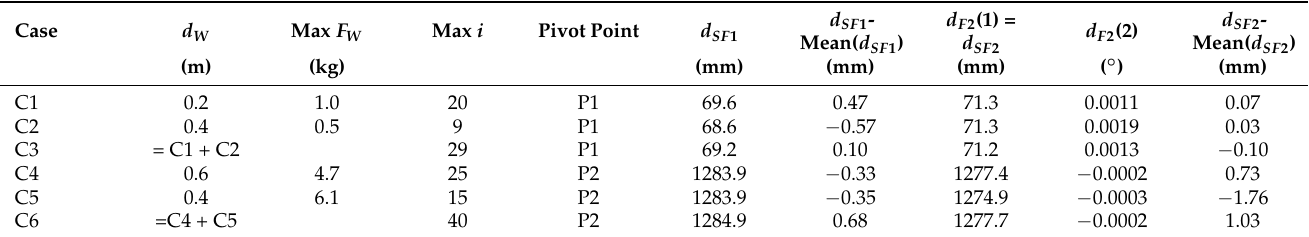
Figure 7. Detailed view of the fitting for the analysis case C1 ( left ) and C4 ( right ) with both functions. Table 2. Overview of the investigated cases and the calculated distance of the CG based on the two different fitting functions SwingF 1 and SwingF 2—mean values for both pivot axis P1 and P2 presented in Table